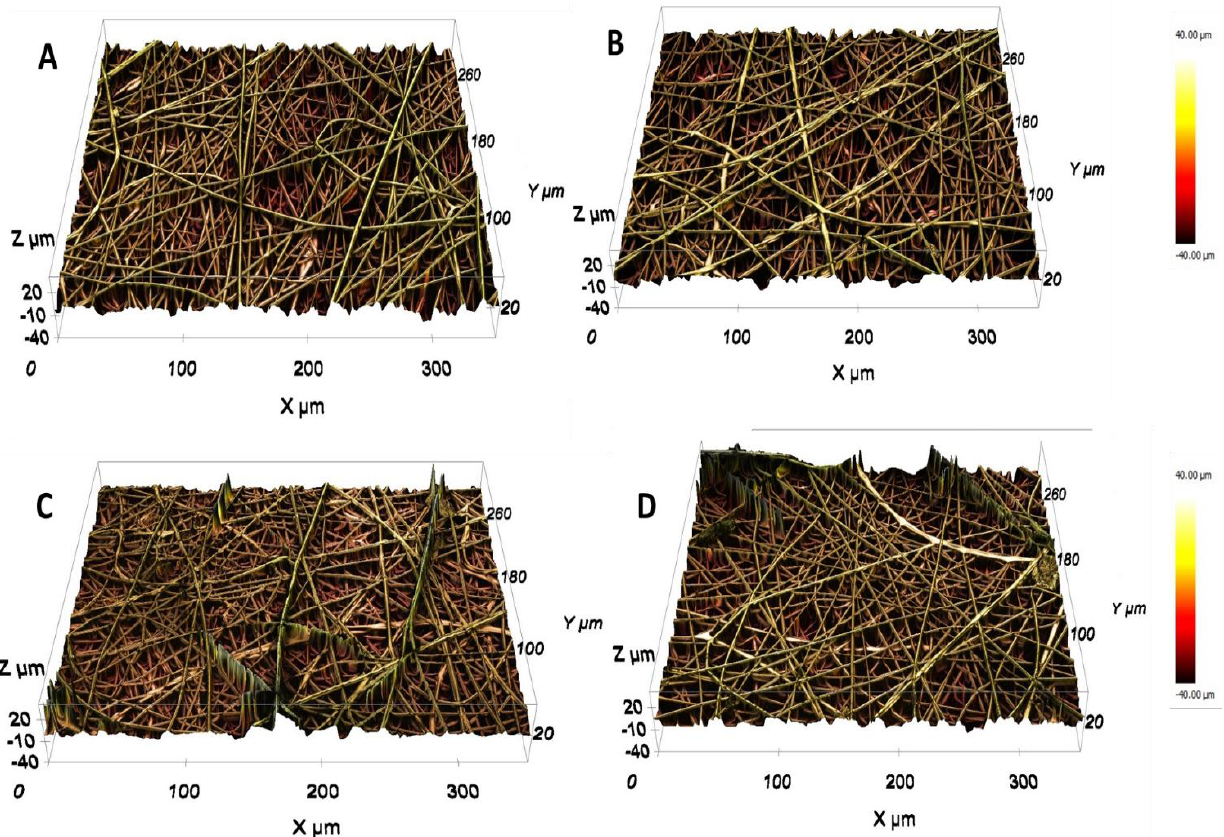
Figure 3. The 3D images of prepared samples obtained by the 3D optical surface metrology system: ( A ) COPA (Sa = 3.4 µ m), ( B ) COHA 0.5 (Sa = 4.5 µ m), ( C ) COHA 1 (Sa = 5.8 µ m), ( D ) COHA 1.5 (Sa = 6.6 µ m); Sa represents the roughness param- eter.